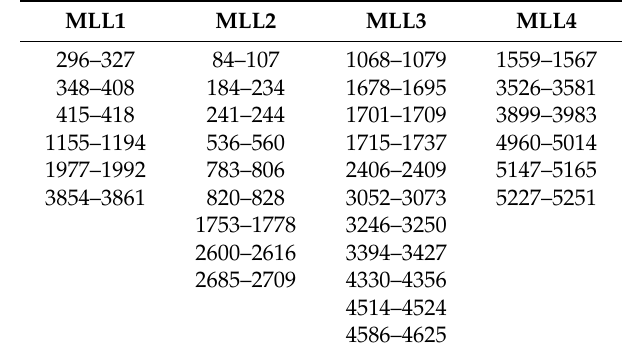
Table 1. Predicted RNA binding regions in the disordered regions of Mixed Lineage Leukemia (MLL) proteins (aa positions).